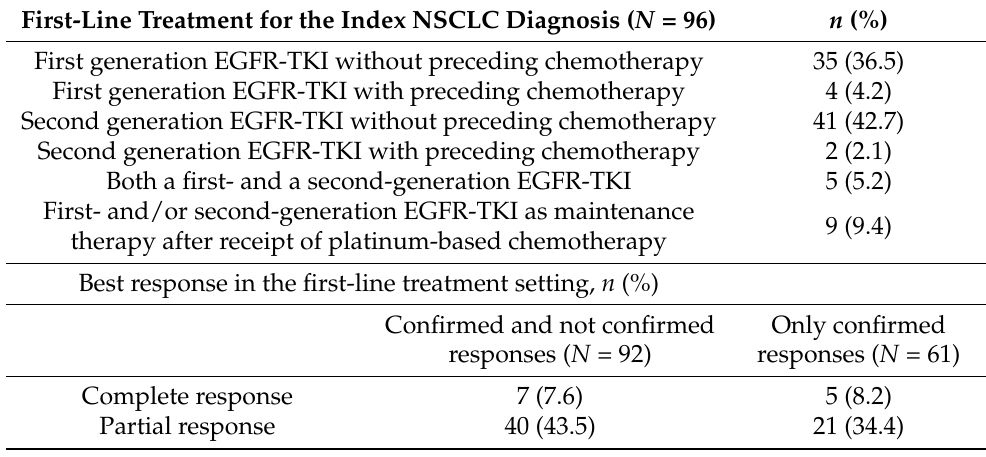
Table 3. NSCLC therapeutic management in the first-line treatment setting and response to